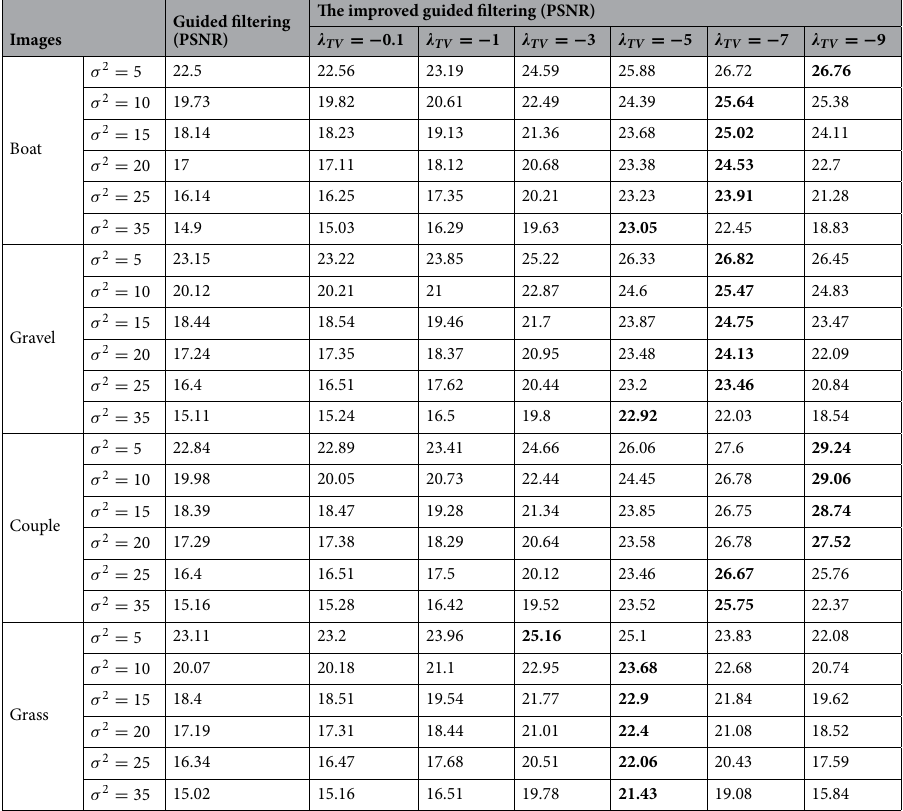
Table 5. The denoising results of the improved guided filtering with different smoothing factors.